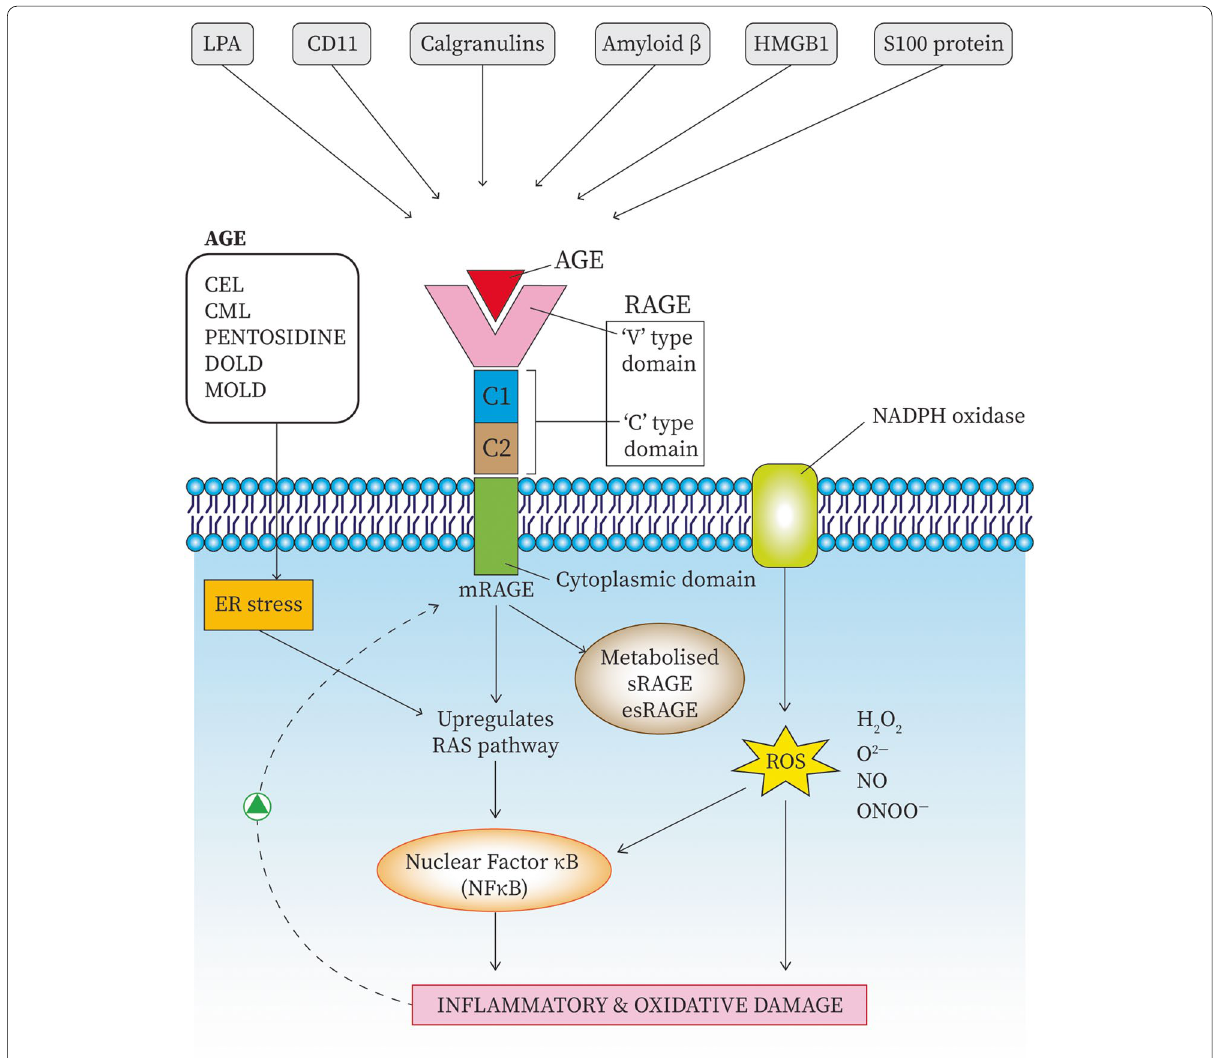
Fig. 3 Receptor for AGE interacts not only with AGEs but also with other ligands like LPA, CD11, calgranulins, amyloid beta, HGMB1, and S100 protein. The interaction of AGEs with AGER initiates a downstream signalling cascade. The primary mediator for the inflammatory pathway is